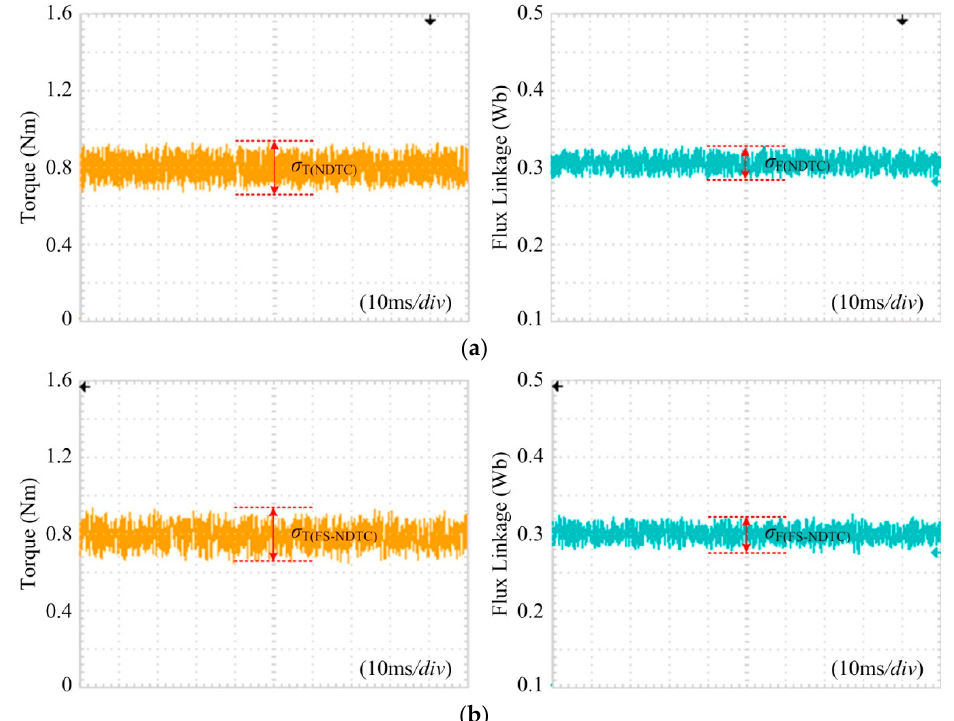
Figure 14. Experimental torque and flux linkage of the PMSM when using: ( a ) NDTC; ( b ) FS-NDTC.